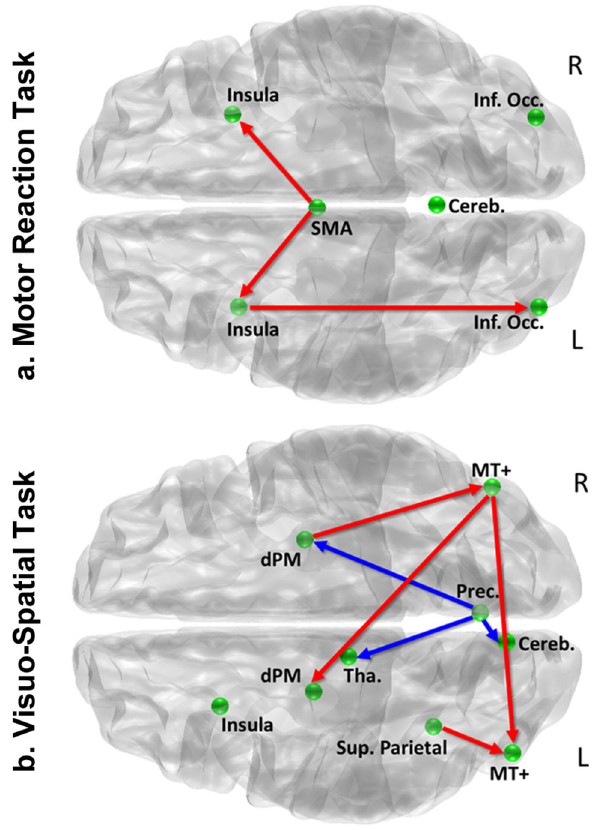
Figure 4. Connectivity Group Comparisons. Statistical map of between group comparisons derived from path coefficients and t-statistics obtained using multivariate autoregressive analysis (MAR) during (a) the motor reaction and (b) the visuo- spatial task. Red and blue arrows respectively indicate significantly greater positive and negative influence on target regions for which a within group effect was also present ( p < 0.05). Here are shown connections that were significantly stronger in professional as compared to naïve drivers (we observed no stronger connections in this latter group).